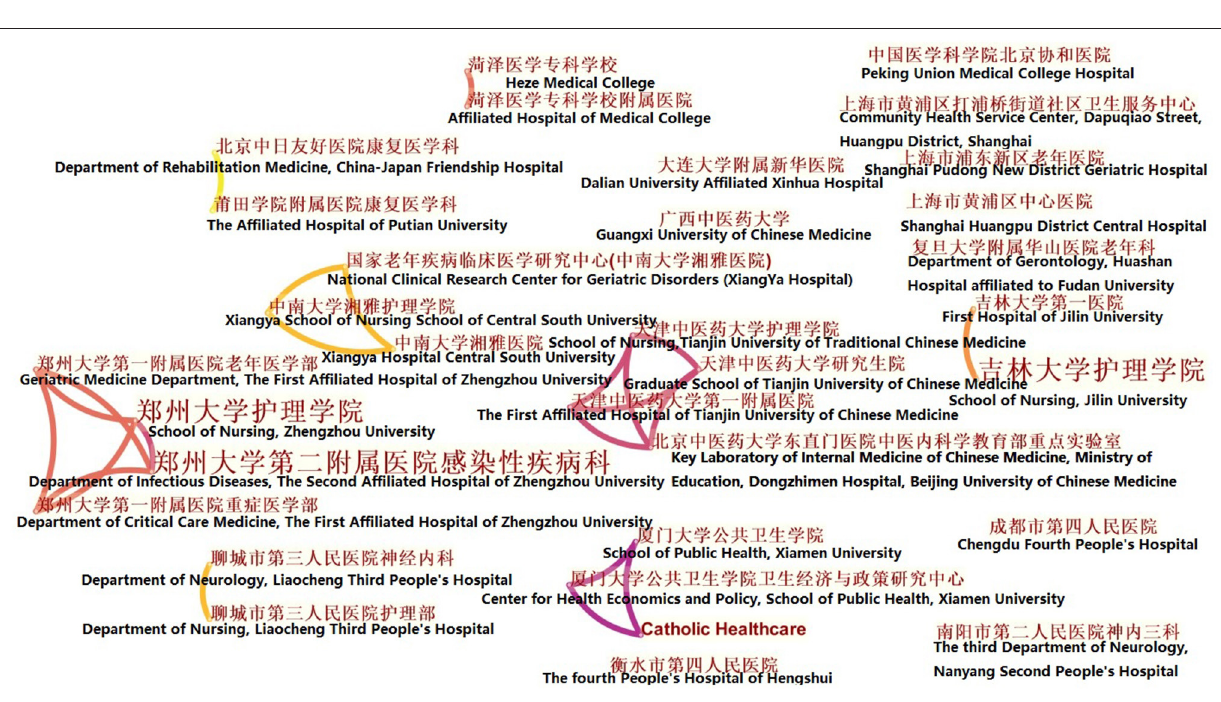
FIGURE 3 | Distribution of institutional publications in the Chinese-language on Montessori approach to interventions for patients with dementia from 2000 to